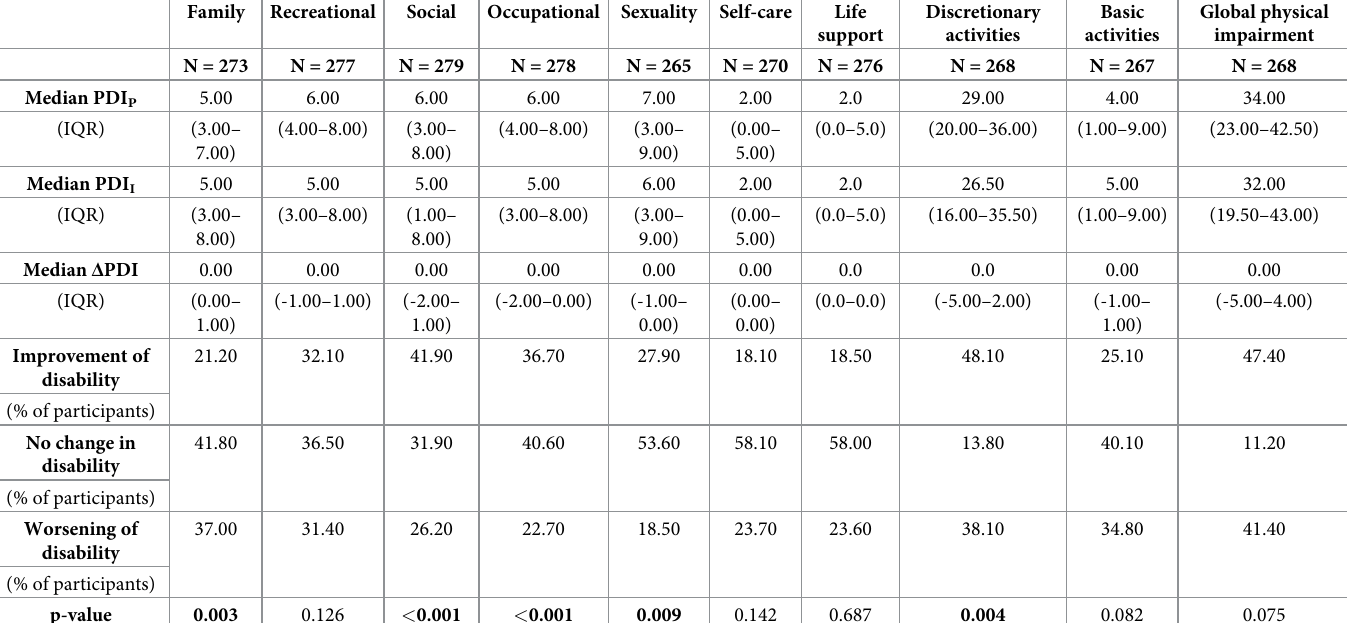
Table 4. Sensitivity analyses of differences of pain disability index ( Δ PDI) during social isolation or quarantine (PDI I ) and previous to social isolation or quarantine (PDI P ) after removing the